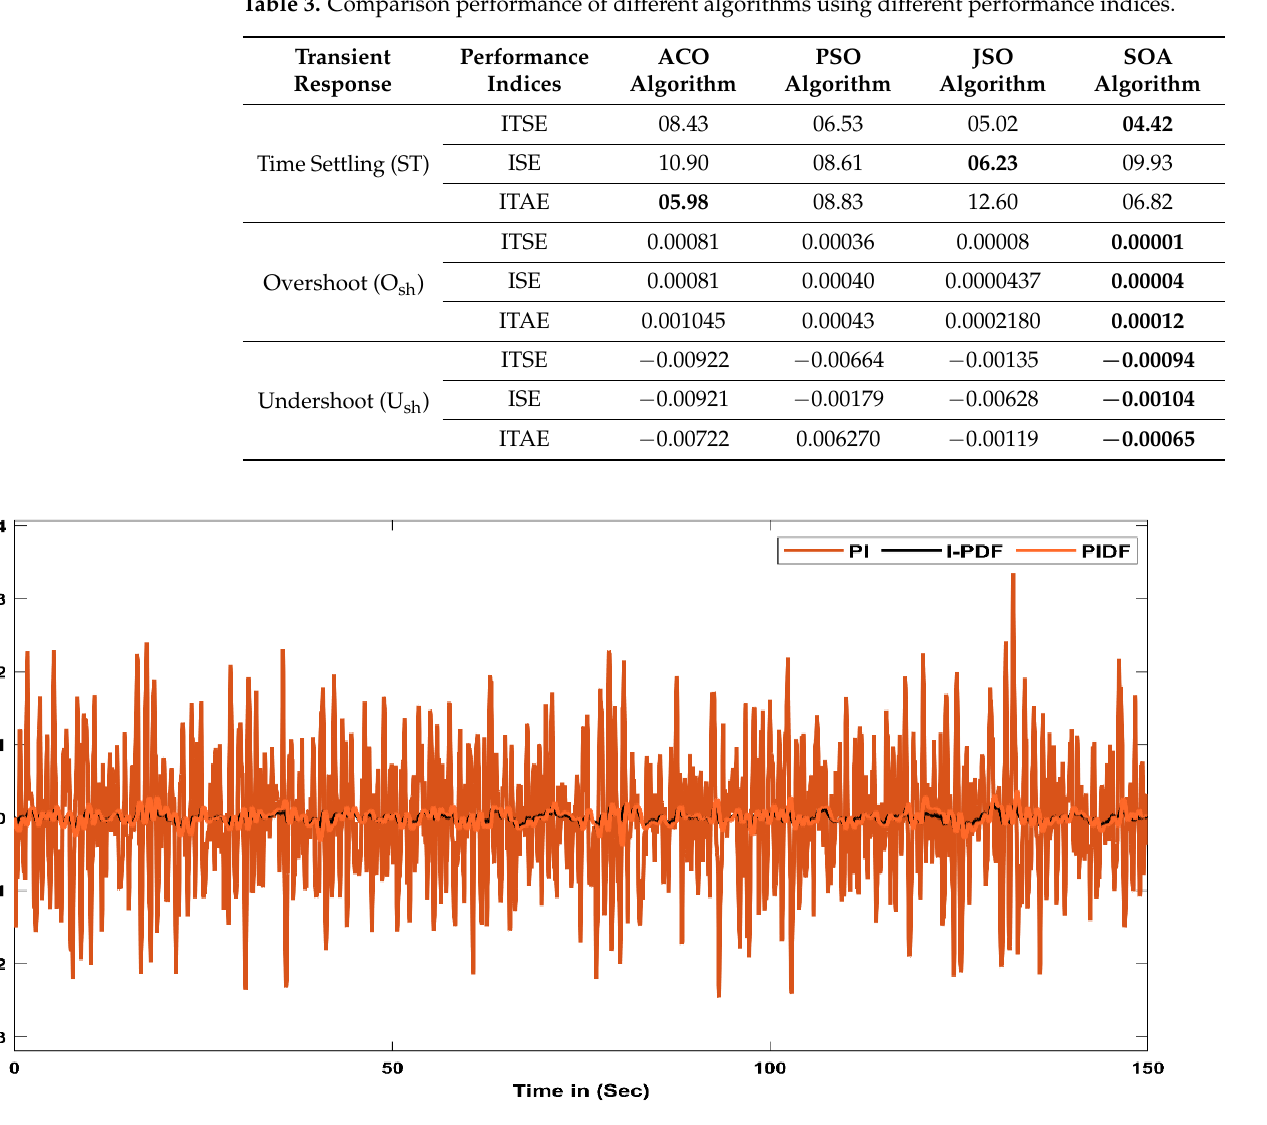
Figure 8. Random load frequency variation of the marine microgrid system.